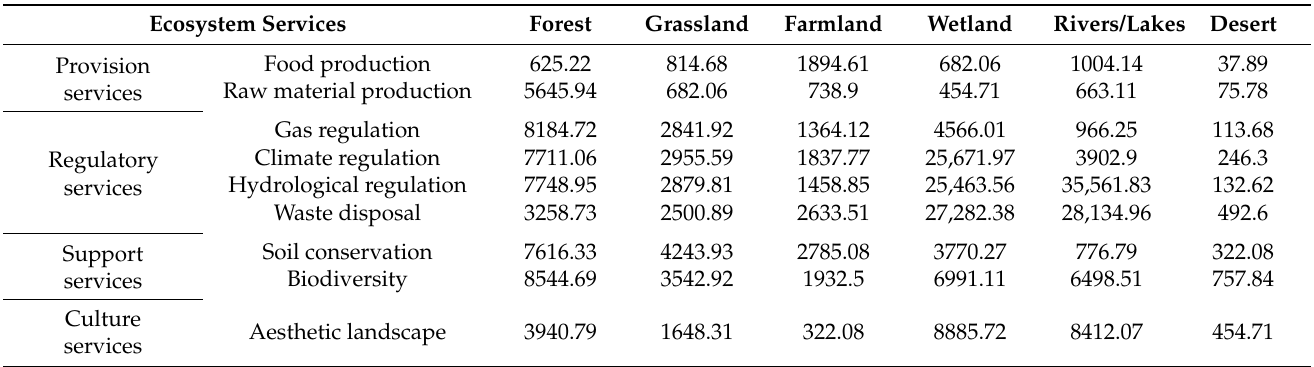
Table 4. ESVs of different ecosystems per unit area (V ci ) in the Central Plains urban